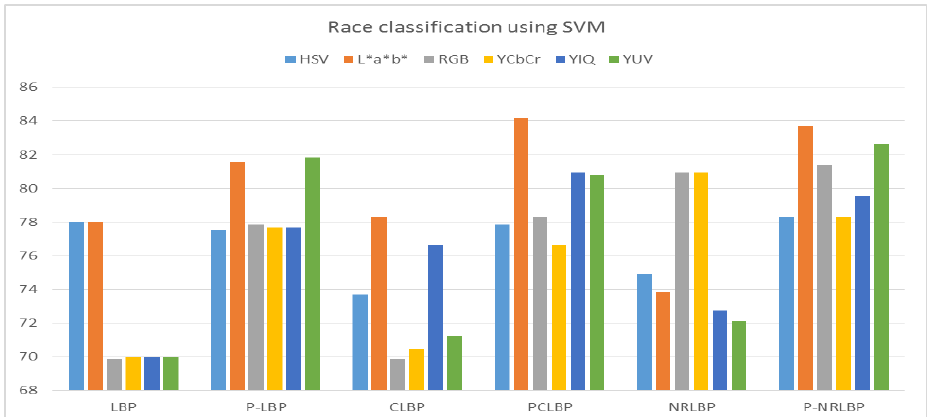
Figure 6. Race classification using SVM (FERET database).